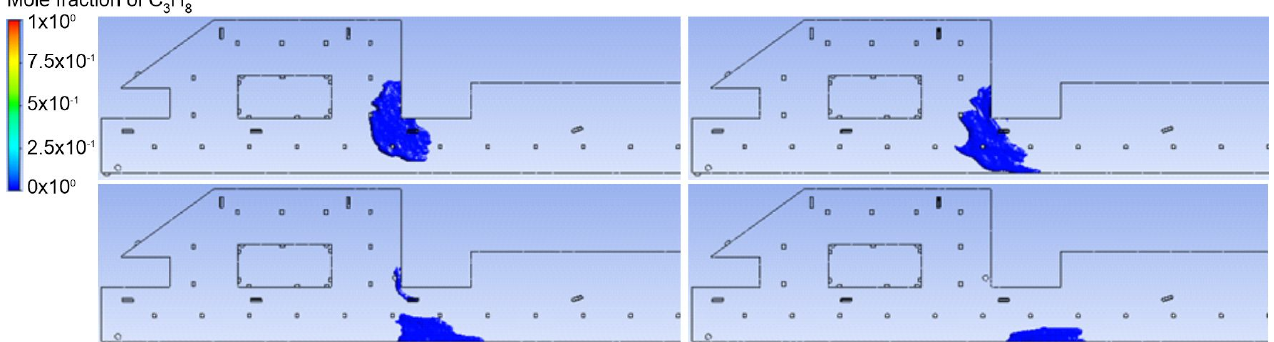
Figure 8. Lower explosive limit of LPG distribution in an underground garage after gas dispersion for B source for different time steps: 15 s, 35 s, 55 s and 70 s.